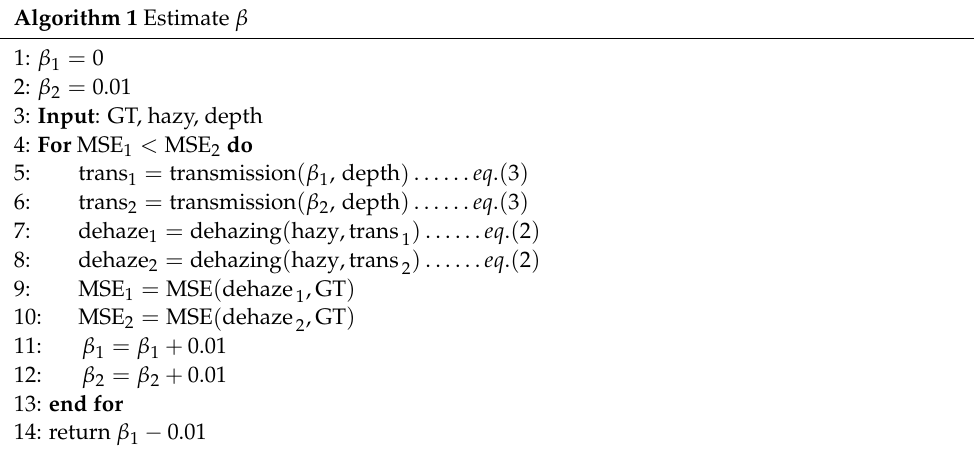
Figure 11. Refine transmission image: ( a ) hazy image; ( b ) grayscale depth image generated from point cloud projection; ( c ) raw transmission image from grayscale depth image; ( d ) refined trans- mission image.